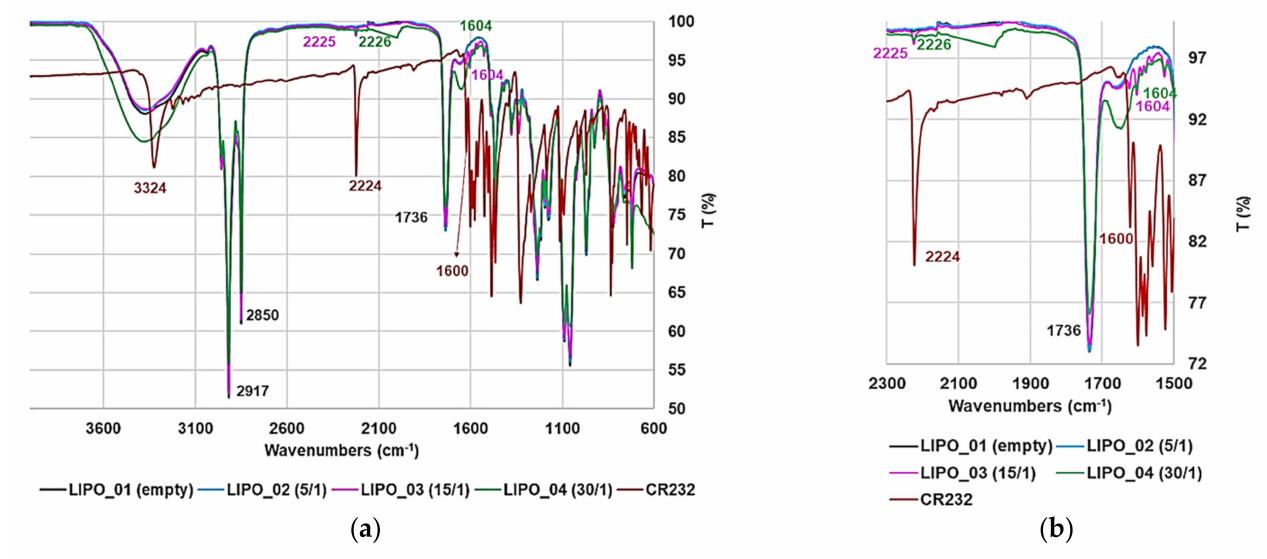
Figure 7. ATR-FTIR spectra of SUVs (black line), CR232 (red line), and CR232-SUVs (5/1 light blue line, 15/1 fuchsia line, and 30/1 green line) ( a ); magnification of a significant spectral region ( b